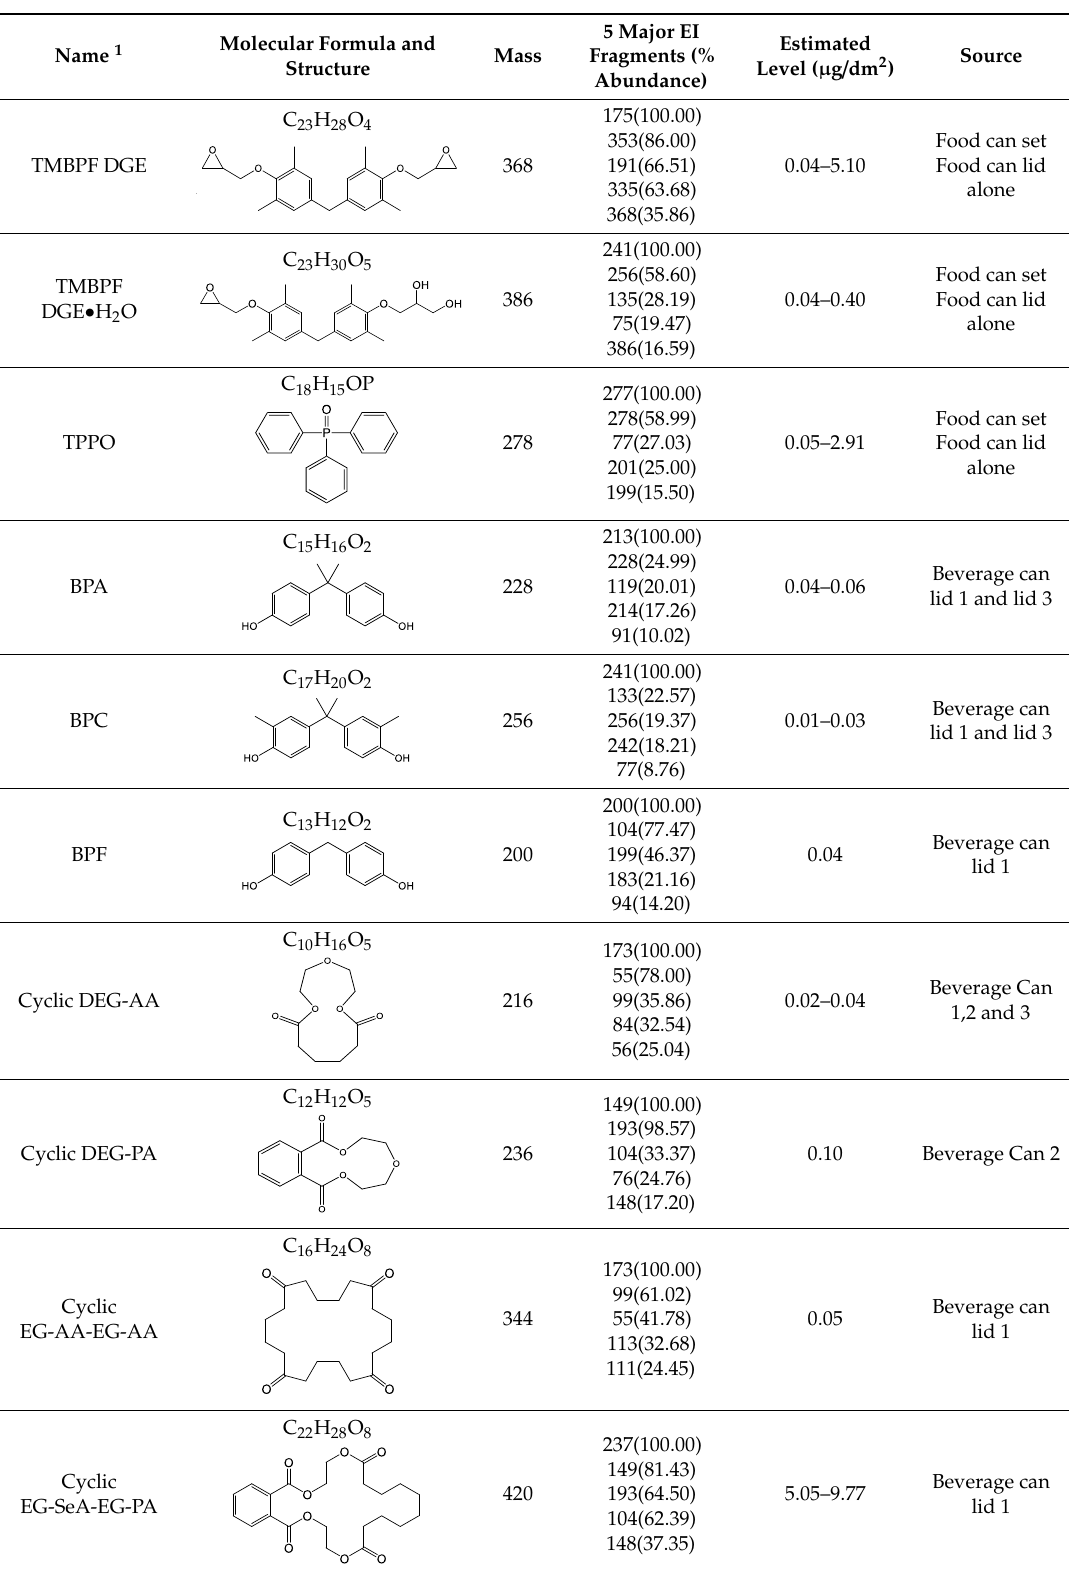
TMBPF Figure 1. High resolution GC-MS Spectra for tetramethyl bisphenol F (TMBPF) and tetramethyl bisphenol F diglycidyl ether (TMBPF DGE).